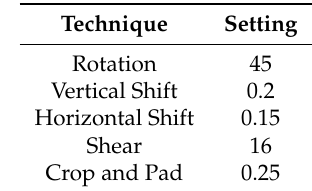
Table 2. Augmentation techniques used in the proposed methodology.